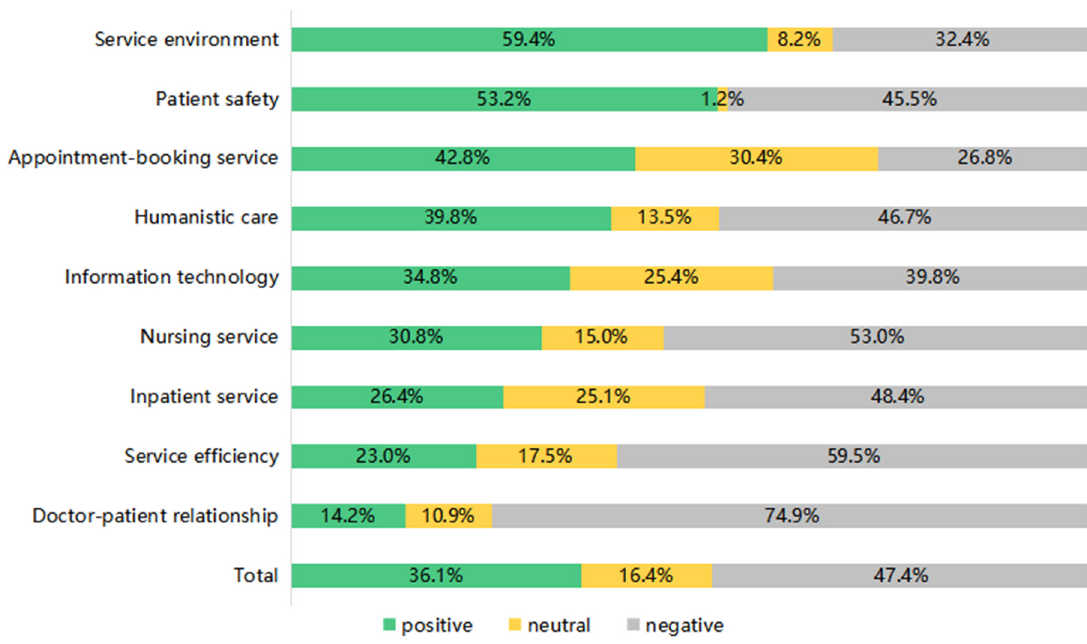
Figure 2. Comparison of sentiment expressed towards the healthcare services topics at overall level.